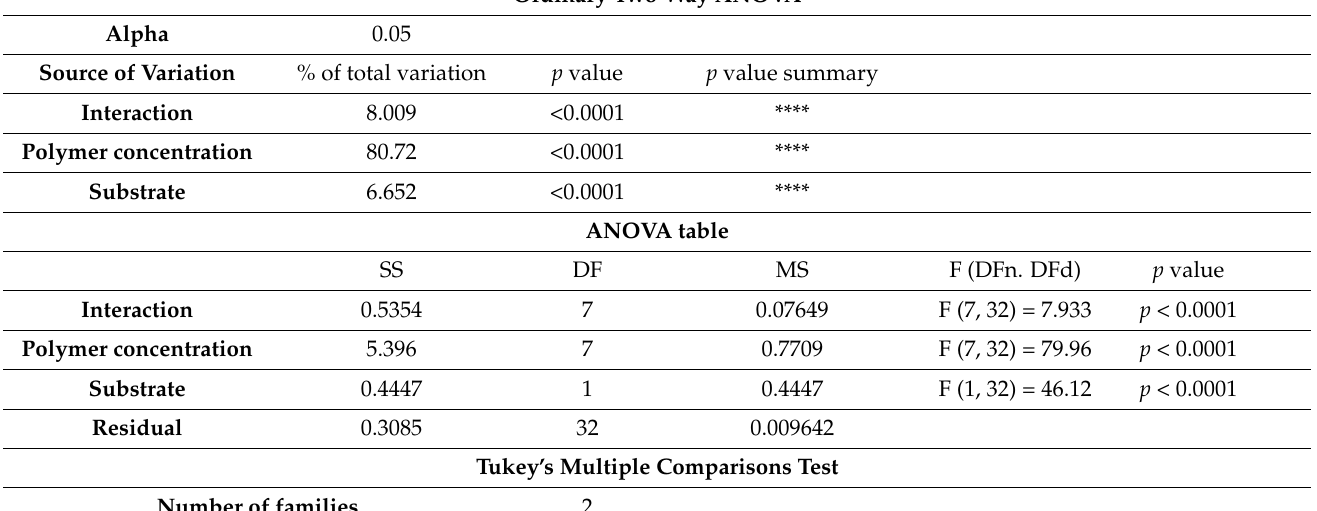
Table A1. Ordinary two-way oviposition ANOVA analysis of HEC2-30 and SA2-30 concentrations and Tukey’s multiple comparisons test to evaluate the effect of. p > 0.0123 = not significant